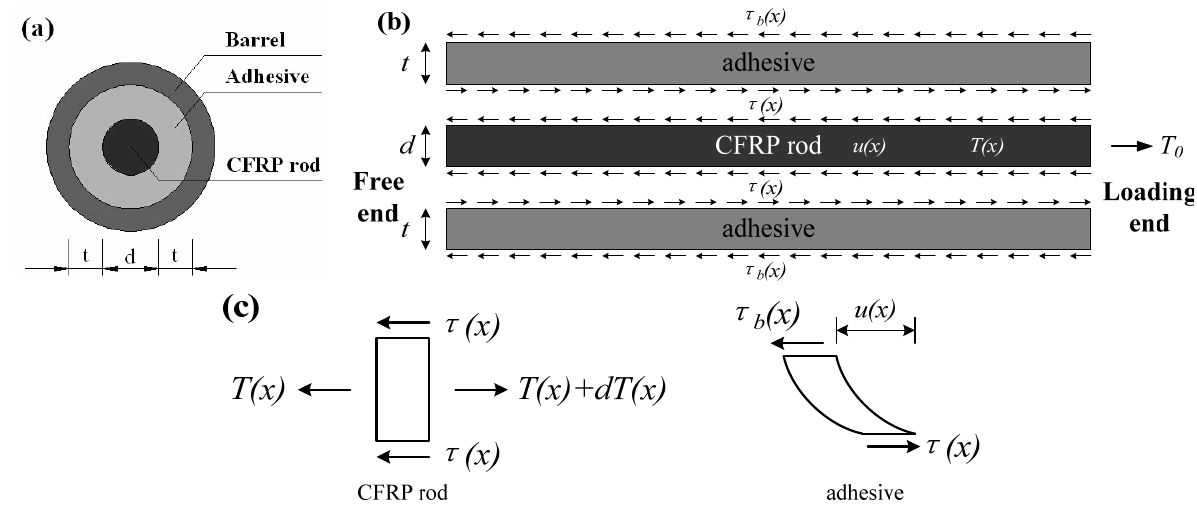
( c ) stress state of a single-rod